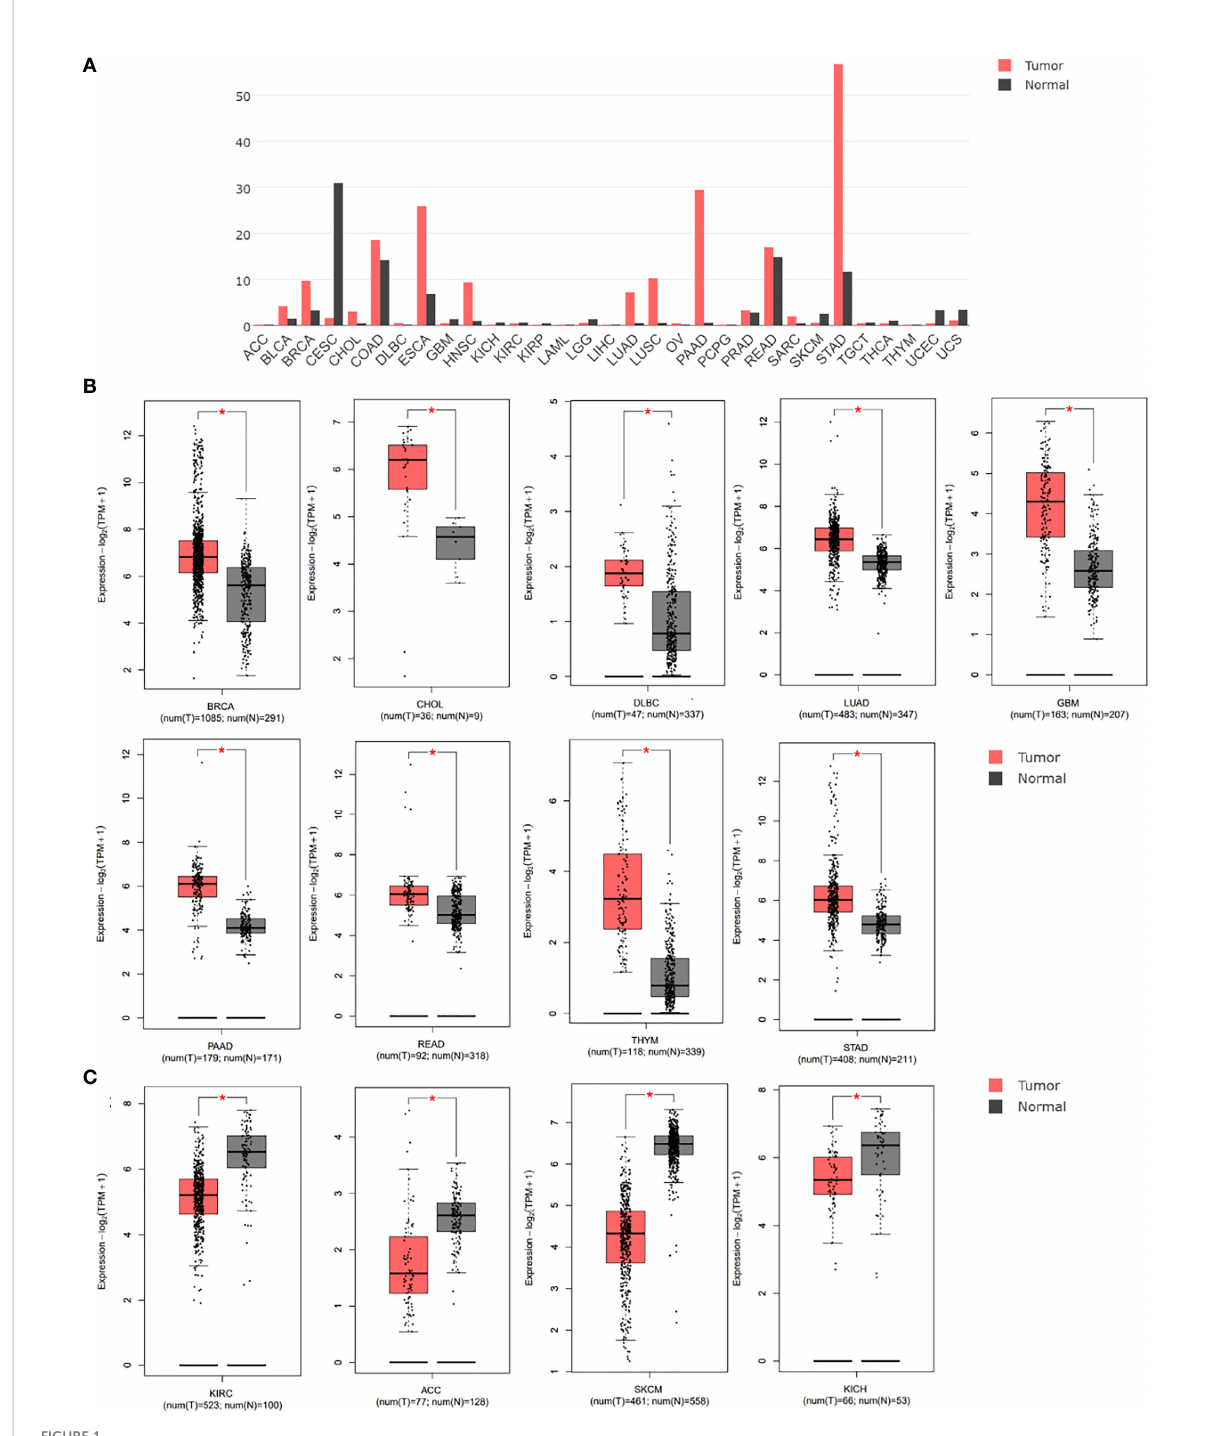
FIGURE 1 Gene expression differences of GREM1 were analyzed using the GEPIA database based on TCGA and GTEx databases. (A) Expression pro fi le of GREM1 expression in 31 tumor types. (B) Higher expression of GREM1 in breast invasive carcinoma (BRCA), cholangial carcinoma (CHOL), lymphoid neoplasm diffuse large B-cell lymphoma (DLBC), lung adenocarcinoma (LUAD), glioblastoma multiforme (GBM), pancreatic ductal adenocarcinoma (PDAC, equal to PAAD used by bioinformatics databases), rectum adenocarcinoma (READ), thymoma (THYM), and stomach adenocarcinoma (STAD). (C) Lower expression of GREM1 in kidney renal clear cell carcinoma (KIRC), adrenocortical carcinoma (ACC), skin cutaneous melanoma (SKCM), and kidney chromophobe (KICH). GEPIA, Gene Expression Pro fi ling Interactive Analysis; TCGA, The Cancer Genome Atlas; GTEx, Genotype-Tissue Expression. * means p-value <